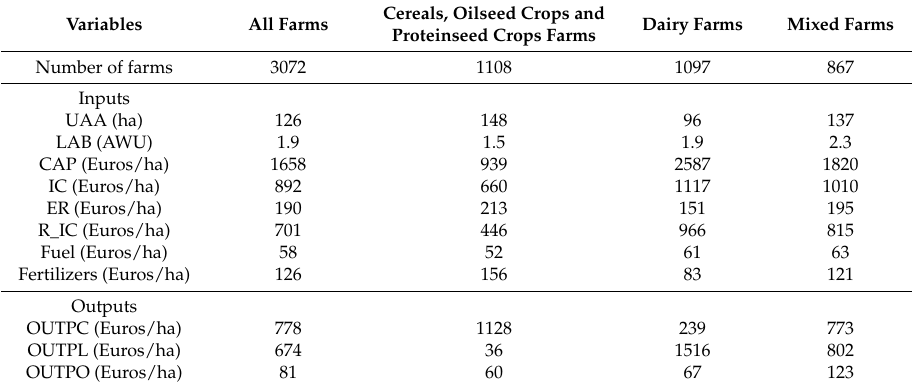
Table 3. Descriptive statistics of the variables used to measure technical efficiency and slacks (averages).